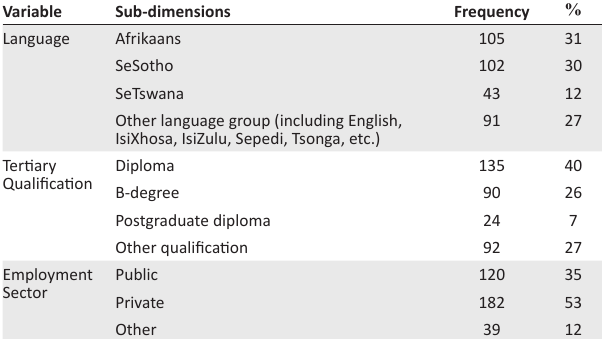
TABLE 1: Additional biographical information of